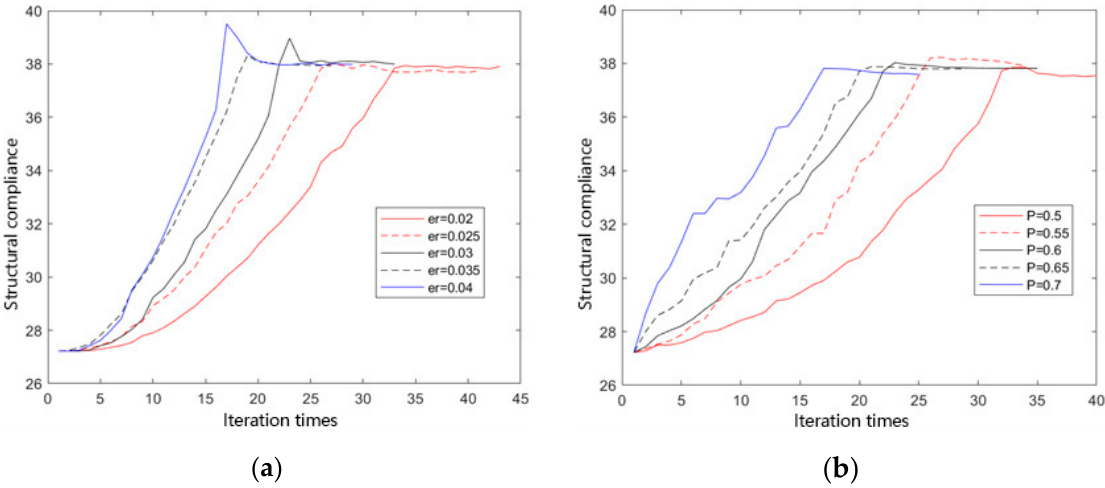
Figure 6. Evolution histories of structural mean compliance at different rates: ( a ) the changes in the structural compliance using different deletion rate; ( b ) the changes in the structural compliance using different minimum variation rate.